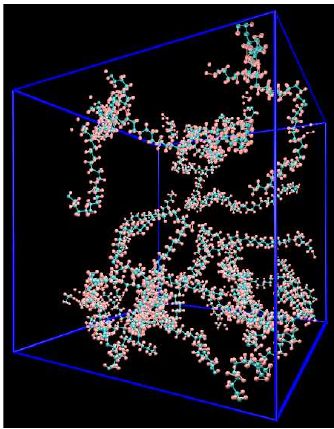
Figure 1. System of PE consisting of 40 PE